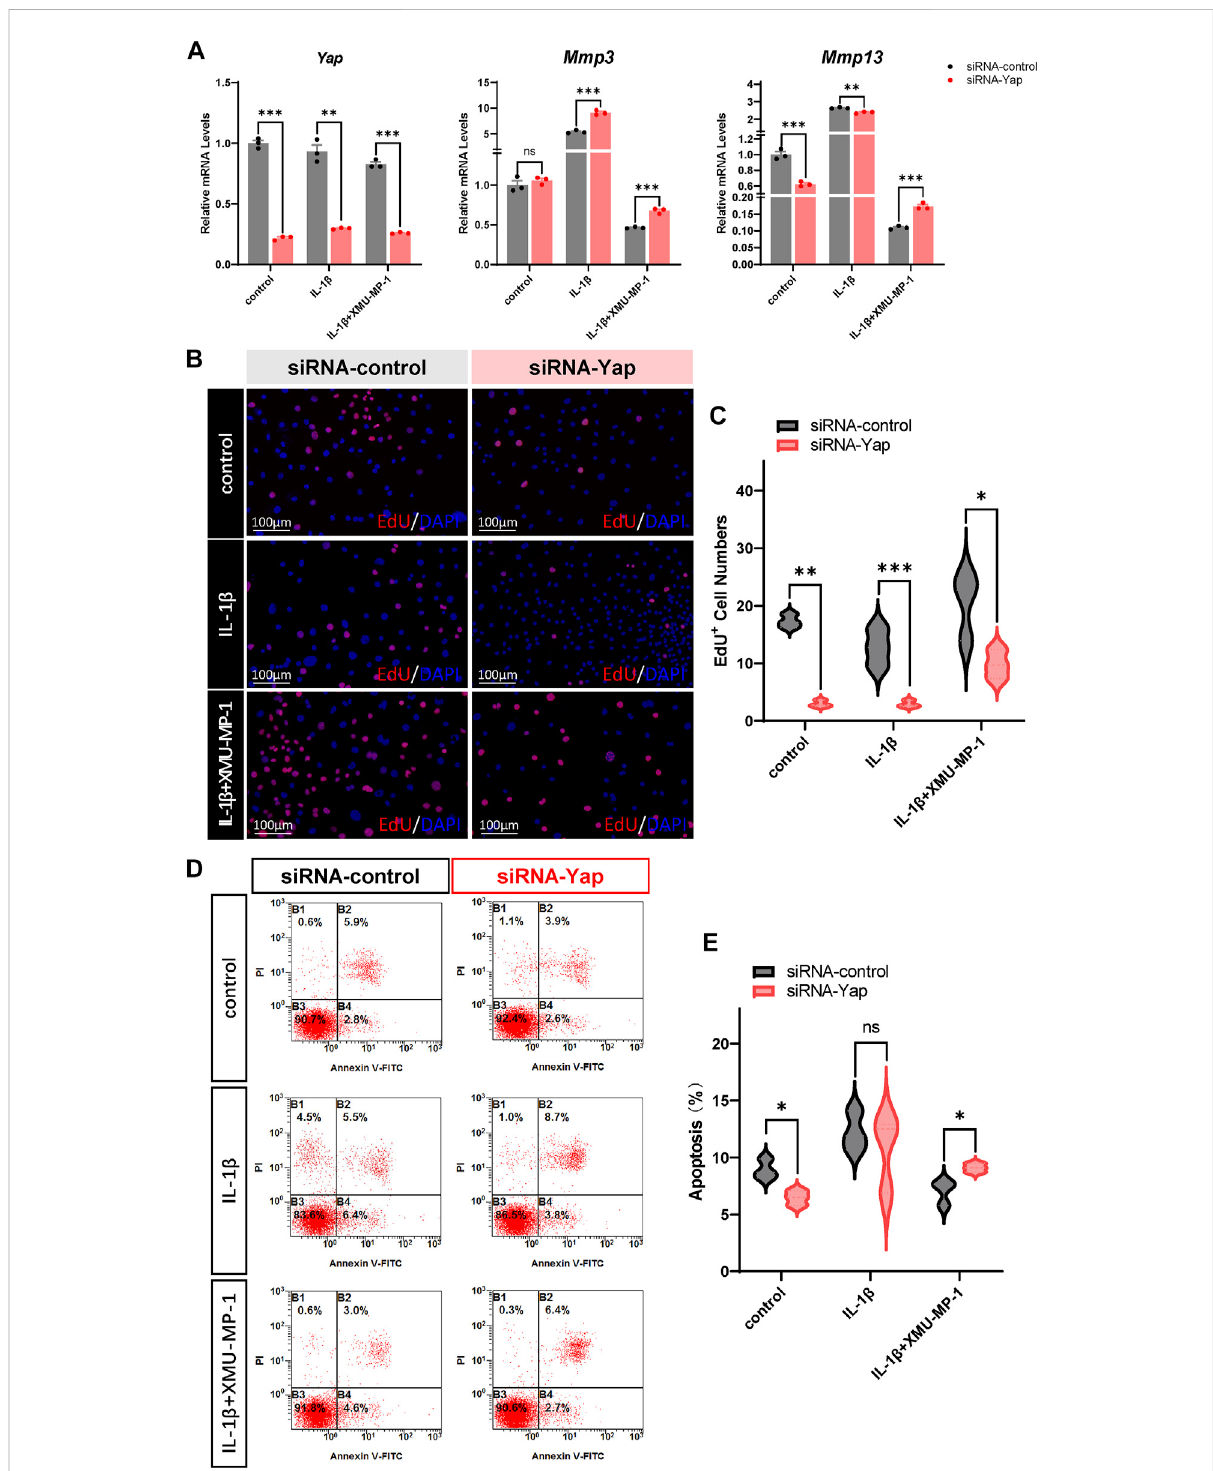
FIGURE 7 YAPplaysacrucialrole inXMU-MP-1chondroprotective functionduring OApathogenesis. (A) RelativemRNA levels of Yap , Mmp3, and Mmp13 in primary chondrocytes transfected with the control or Yap siRNA, treated with IL-1 β or/and XMU-MP-1. (B) Representative images of EdU labeling chondrocytes transfected with the control or Yap siRNA, treated with IL-1 β or/and XMU-MP-1. Cells stained with a fl uorescent dye (red) and DAPI (nuclei,blue). (C) StatisticalanalysisoftheEdU + chondrocytesnumbersinB. (D) Representative fl owcytometrygraphsinprimarychondrocytes transfectedwiththecontrolor Yap siRNA,treatedwithIL-1 β or/andXMU-MP-1. (E) StatisticalanalysisofapoptoticcellsinD.Alldataarepresentedas mean ± SEM. ns p > 0.05, * p <